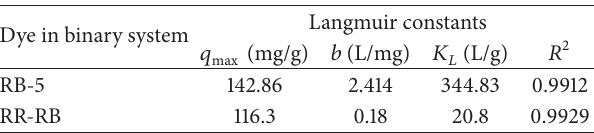
Figure 10: Effect of contact time on the removal of RB-5 dye in the presence of RR-RB dye (binary system) (temp. = 25 ∘ C, speed = 200 rpm, dose = 0.1 g/100mL, and con. of RR-RB = con. of RB-5). Table 4: Langmuir isotherm constants for RB-5 and RR-RB in binary system.